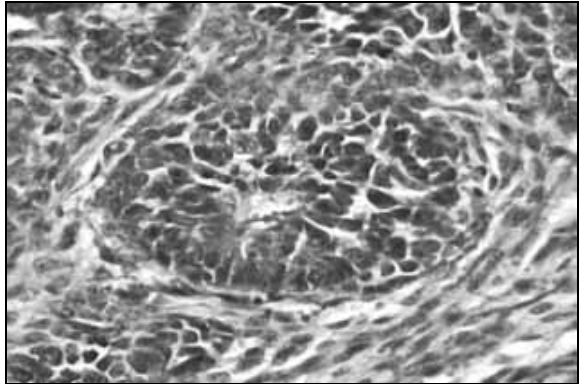
Figura 3 – Coloração por hematoxilina e eosina, aumento de 200 vezes. Observa-se ni- nho de pequenas células tumorais redondas e coesas, envoltas por denso estroma fibroso Ao longo dos 18 meses seguintes o paciente foi submeti- do a tratamento com ciclos de radioterapia e quimioterapia, esta última em esquema de etoposídeo e ifosfamida,